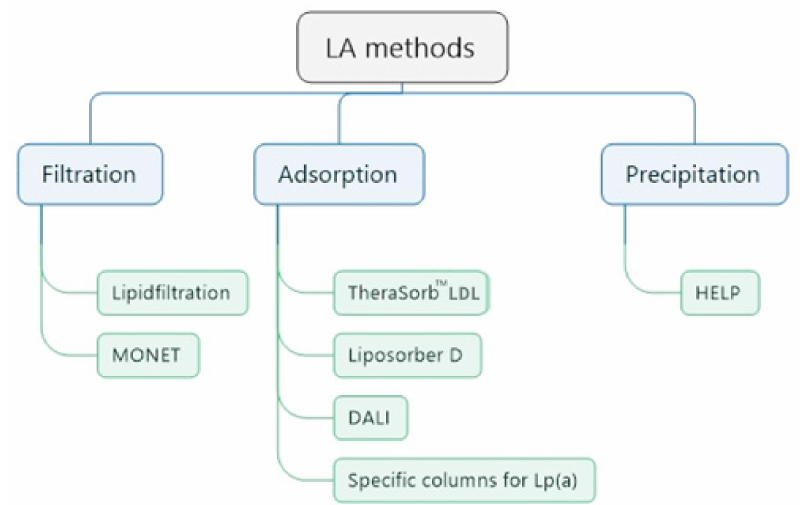
Figure 3. Principles of available LA